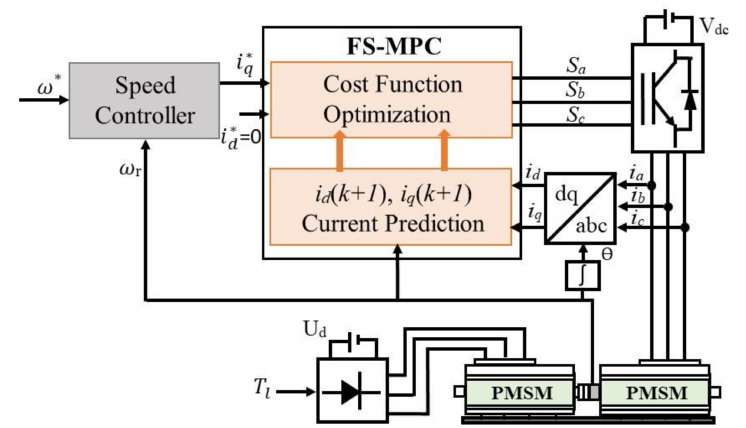
Figure 2. Schematic diagram of the finite-set model-predictive control (FS-MPC)-based PMSM